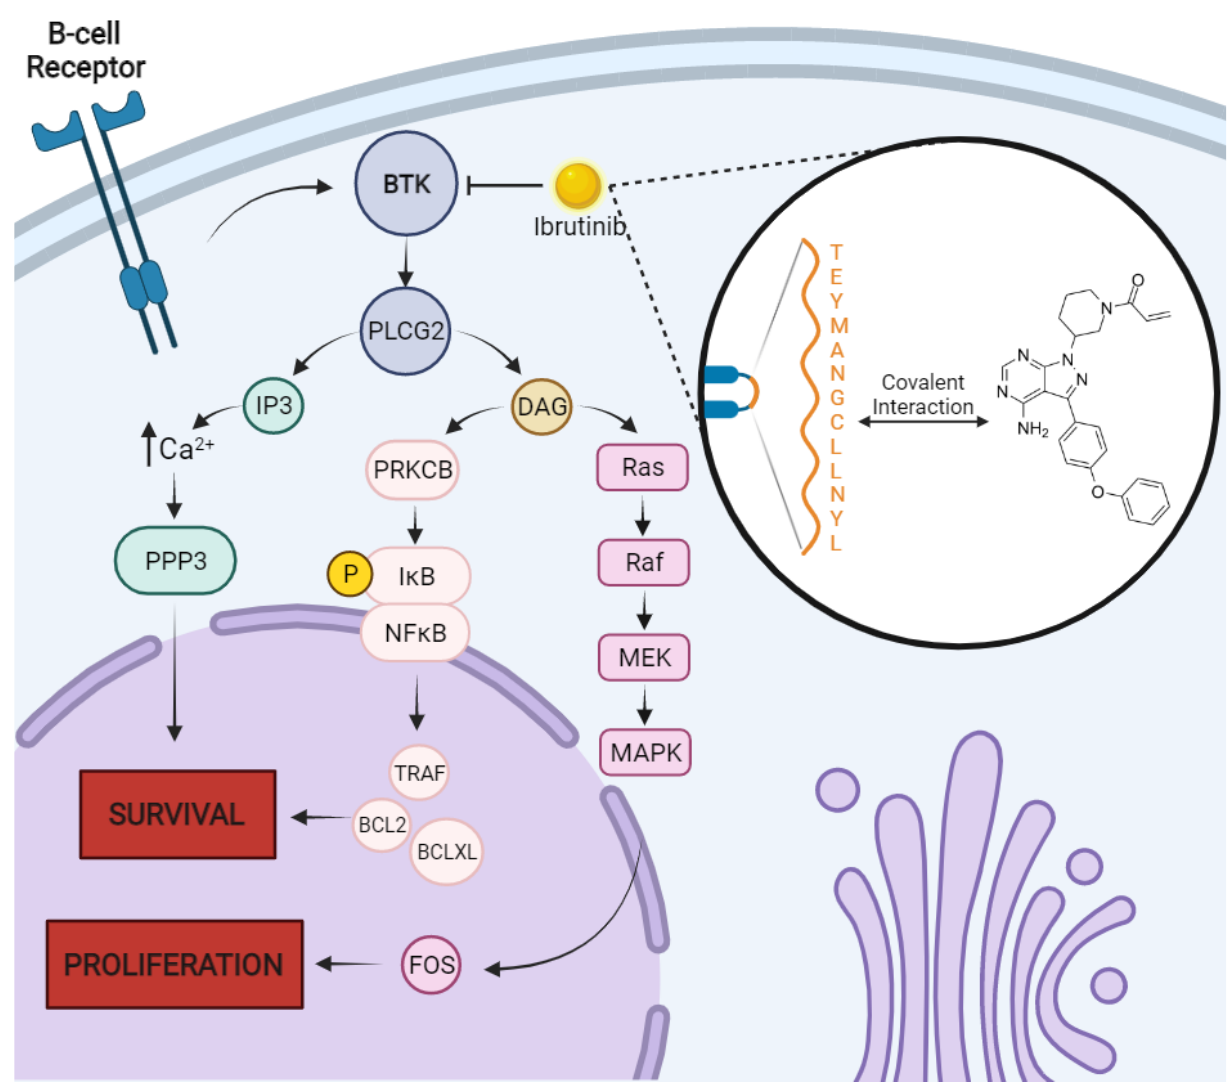
Figure 2. Bruton’s tyrosine kinase (BTK) survival and proliferation pathways and interaction with ibrutinib. In multiple myeloma (MM), B-cell receptors of malignant plasma cells signal for BTK cascade to begin, which is highly overexpressed and induces survival and proliferation of neoplastic clones. Downstream activity happens mainly through phospholipases which catalyze formation of IP3 (inositol 1-4-5 trisphosphate) and DAG (diacylglycerol), being effectors of intracellular calcium signaling pathways, in the case of IP3, and NF κ B and MAPK signaling pathways, in the case of DAG. Inhibition of BTK by ibrutinib, however, can drastically disrupt the metabolism of MM cells and happens through the covalent and irreversible interaction of ibrutinib with the cysteine residue on position 481 of the BTK active domain. Created with